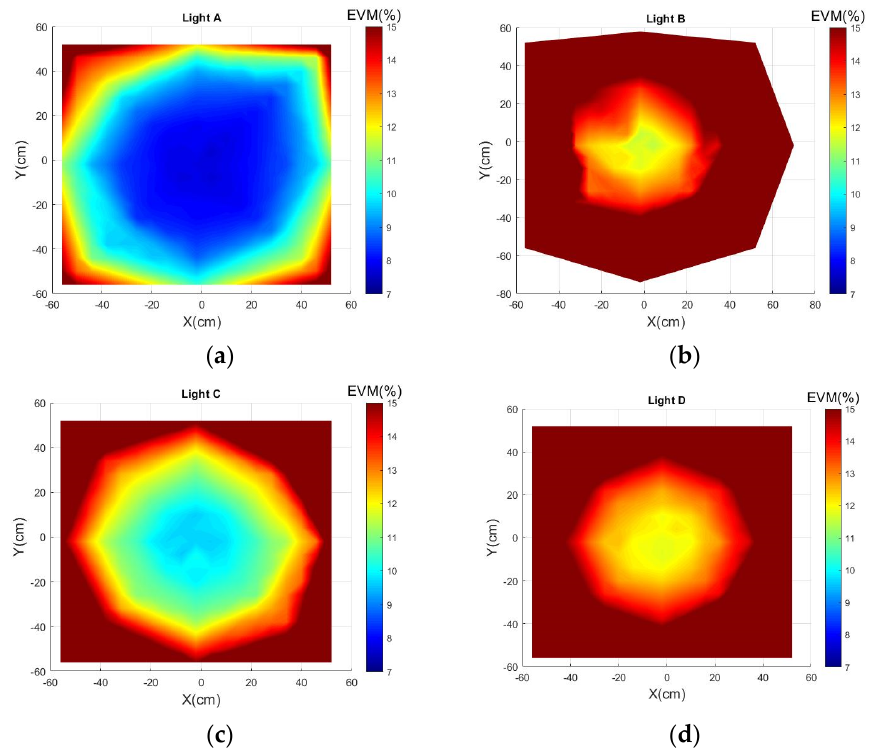
Figure 5. EVM distribution of LED in testbed: ( a ) EVM@LED-A; ( b ) EVM@LED-A; ( c ) EVM@LED-C; ( d ) EVM@LED-D.